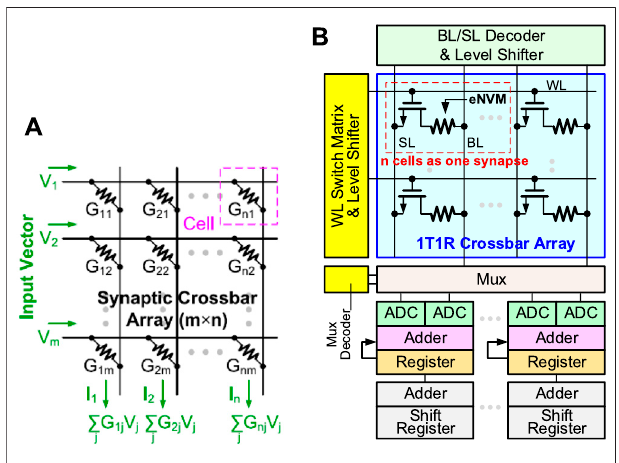
FIGURE1|(A) Weightedsum(MAC)operationinaconceptualcrossbar array structure. (B) RRAM-based sub-array with peripheral circuits (e.g., CIM